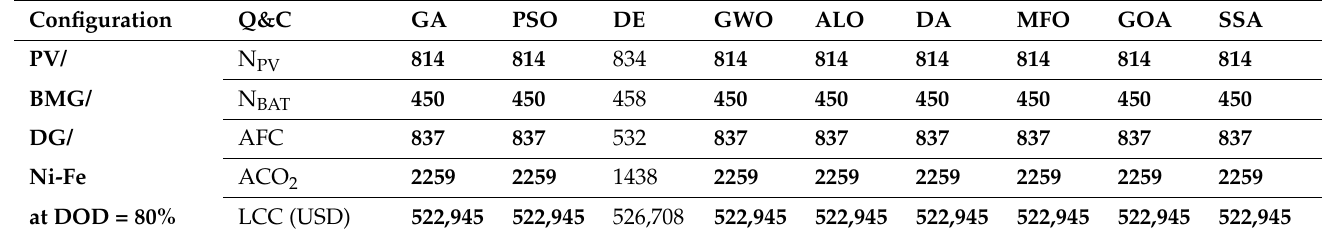
Table 12. Optimization results of the LPRAHC-based IHRES using LF strategy at LPSP value of 0%.